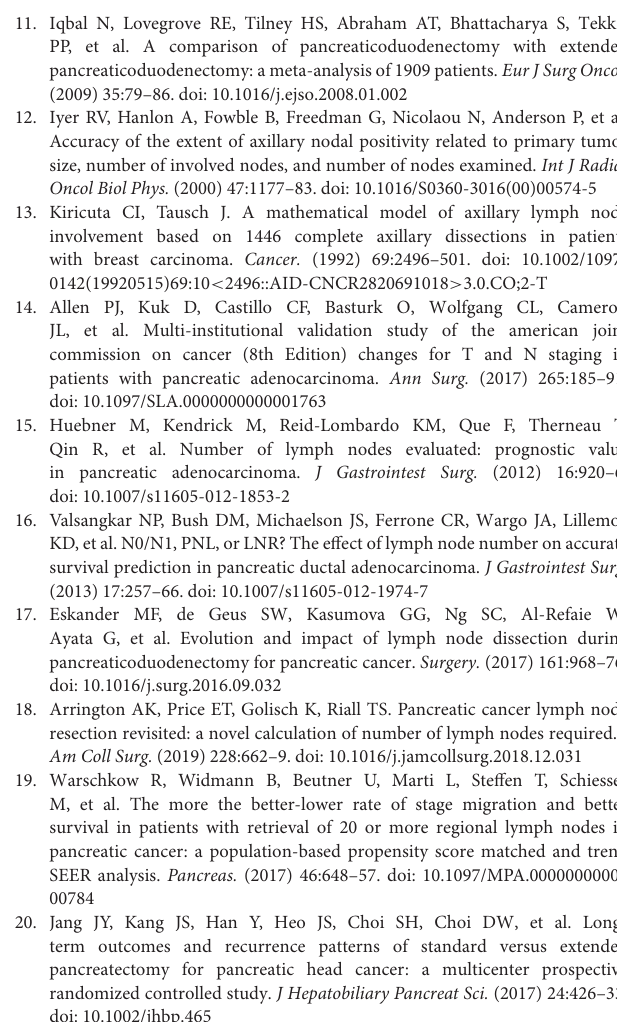
Supplementary Table 1 | The AJCC 8th TNM staging